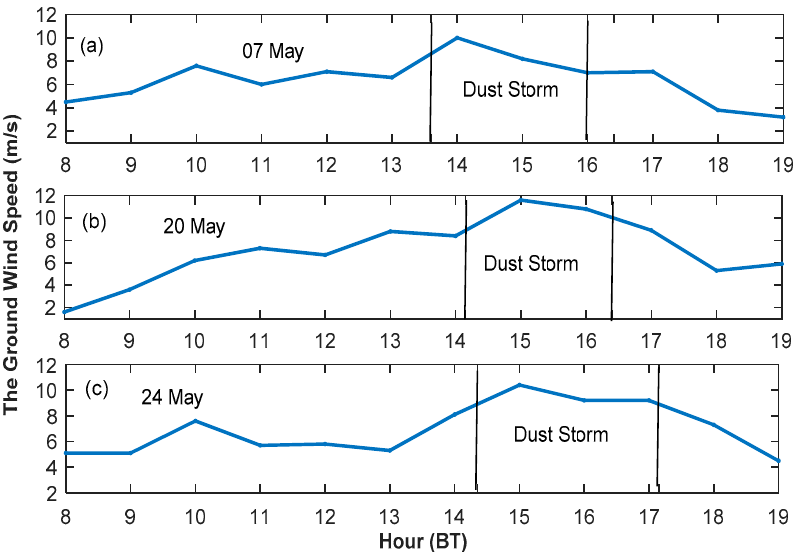
Figure 6. The ground wind speed on ( a )7 May, ( b ) 20 May and ( c ) 24M ay.